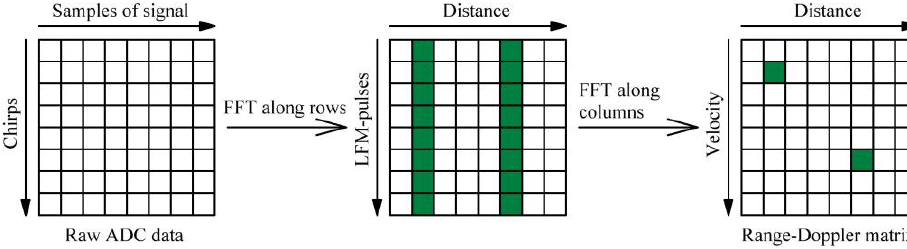
Fig. 2. Range-Doppler matrix creation process.